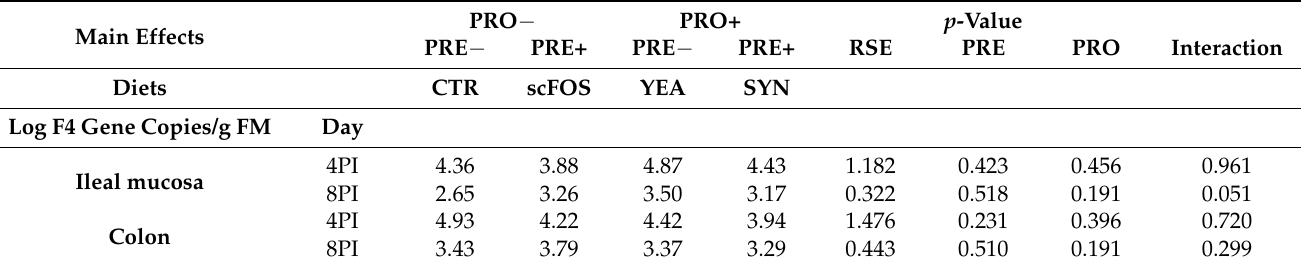
Table 5. Numbers of F4 genes in ileal mucosa and colon digesta according to qPCR (in quantifiable animals). Values were measured at day 4 and 8 post